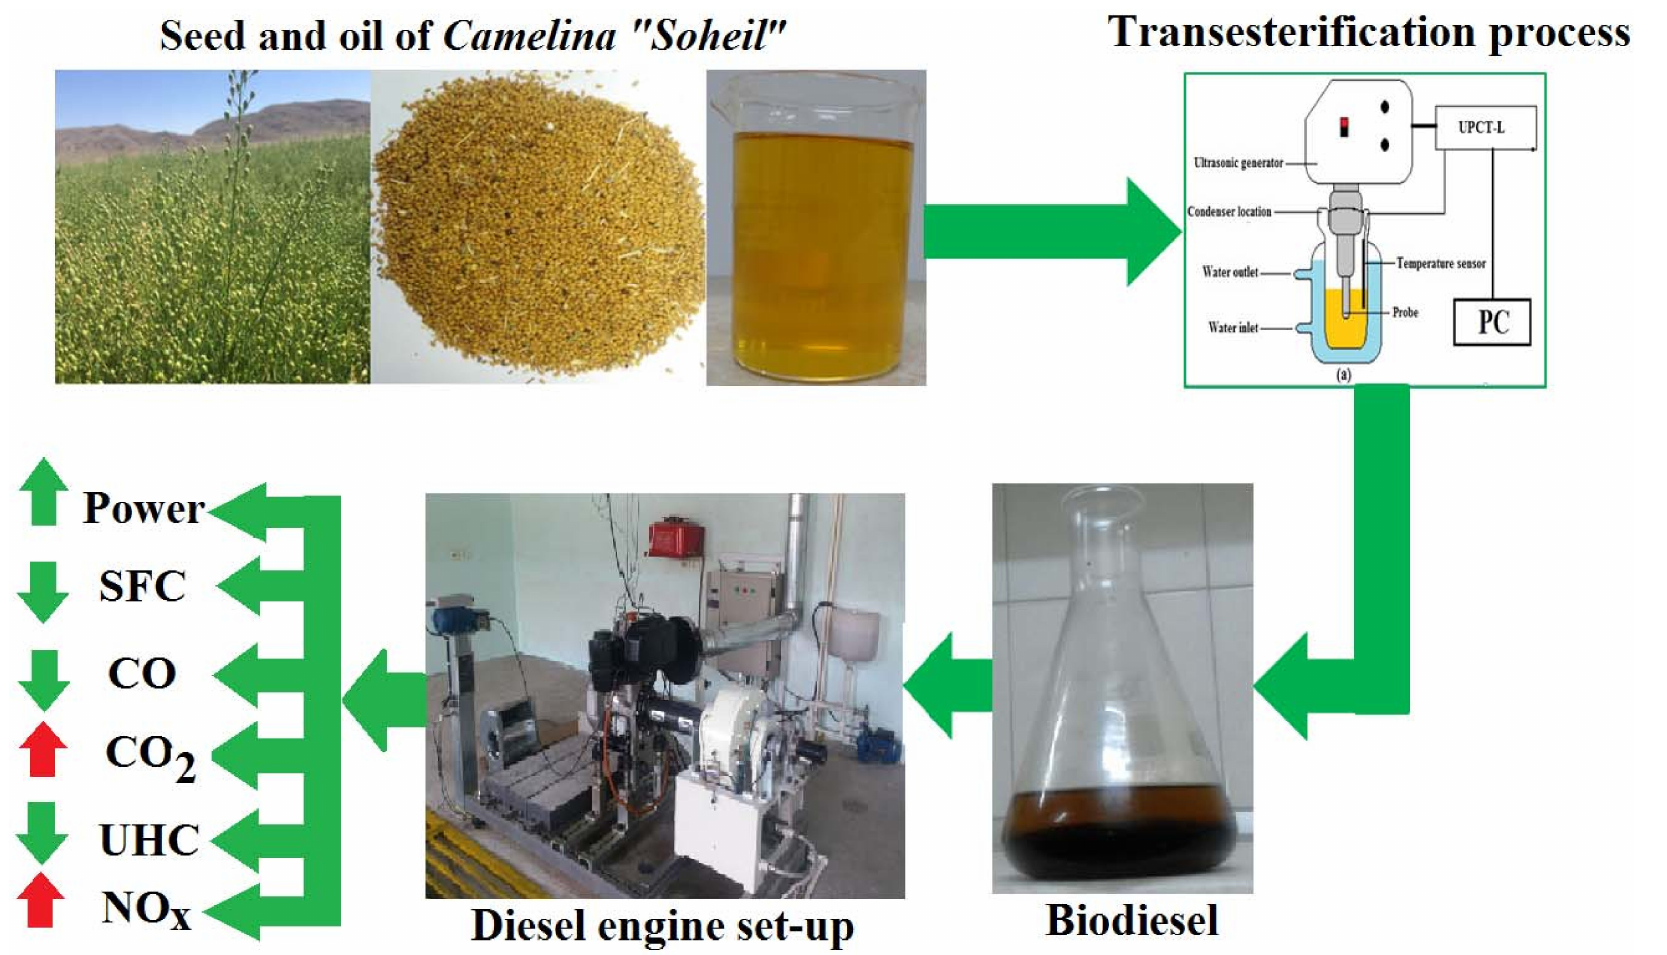
Figure 11. Impact of the Camelina “Soheil” biodiesel on various engine